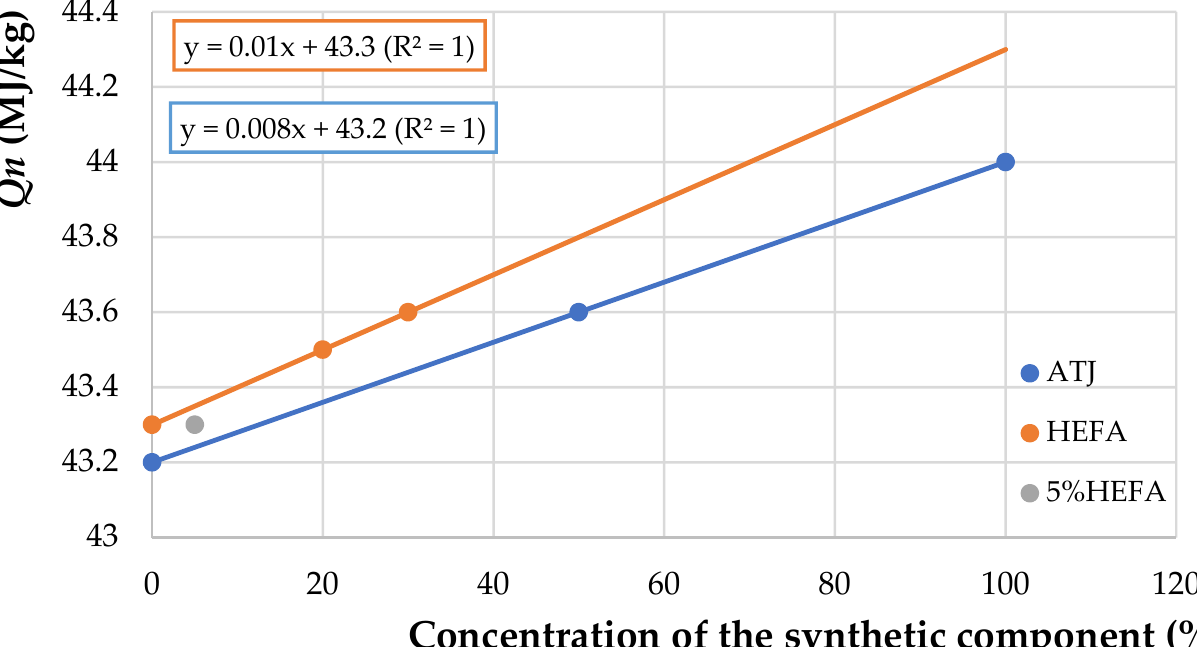
Figure 7. The relationship between calorific value Q n of the tested blends and the concentration of a synthetic component; properties of the blend containing 5% of HEFA differ from the relationship found for blends containing HEFA in higher concentration.